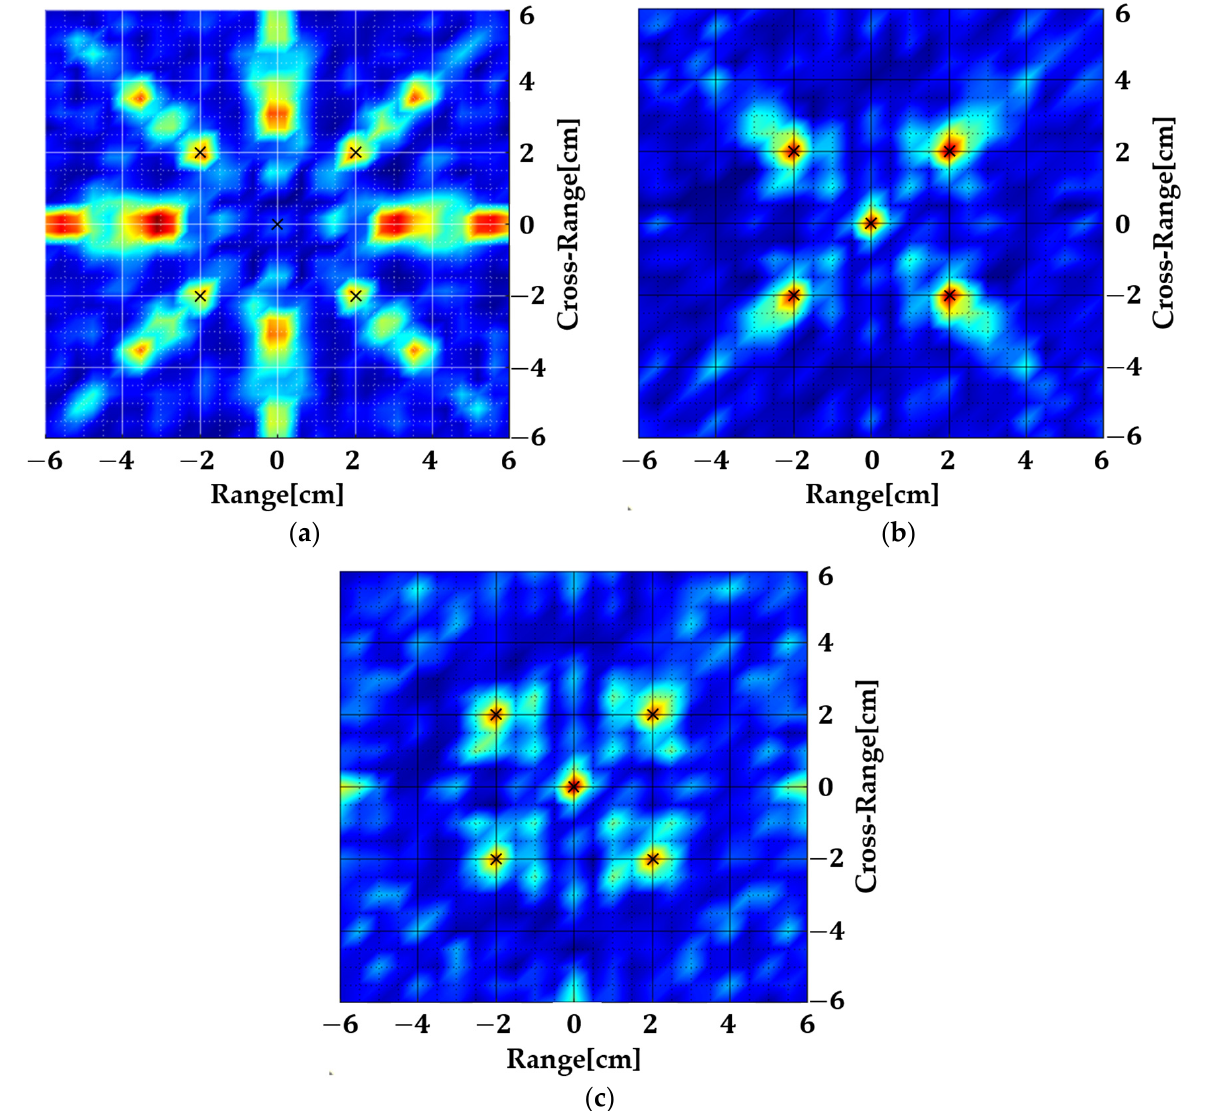
Figure 4. Near-field ISAR images of the geometry shown in Figure 3, ( a ) considering only the first exponential term, ( b ) considering the first two exponential terms, and ( c ) considering all terms.